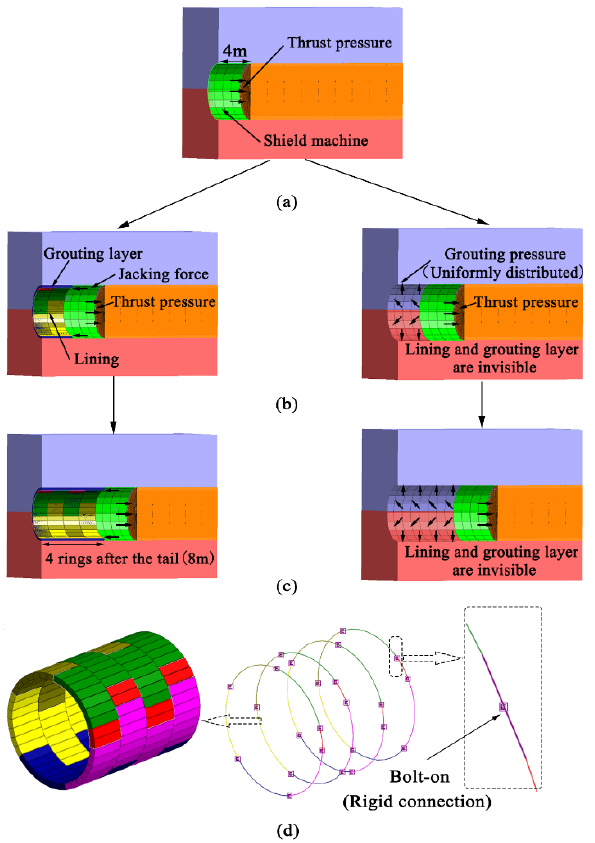
Figure 6. Midas GTS simulation shield construction flow chart: ( a ) excavation process; ( b ) lining ring assembly process; ( c ) synchronized grouting process; ( d ) lining ring assembly detail.